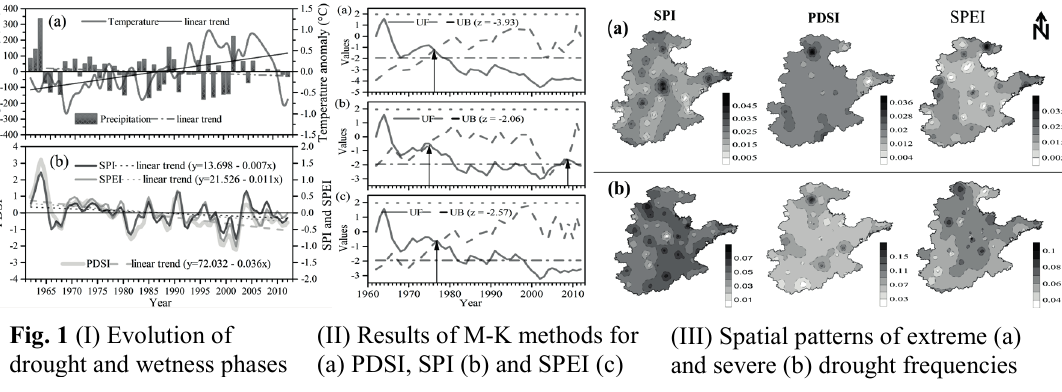
Fig. 1 (I) Evolution